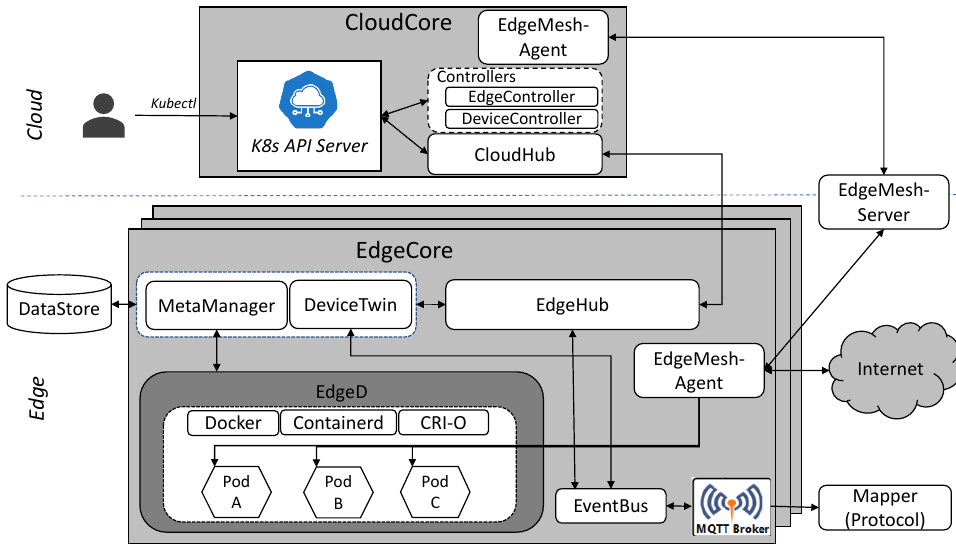
Figure 1. KubeEdge architecture and its components in cloud and edge.